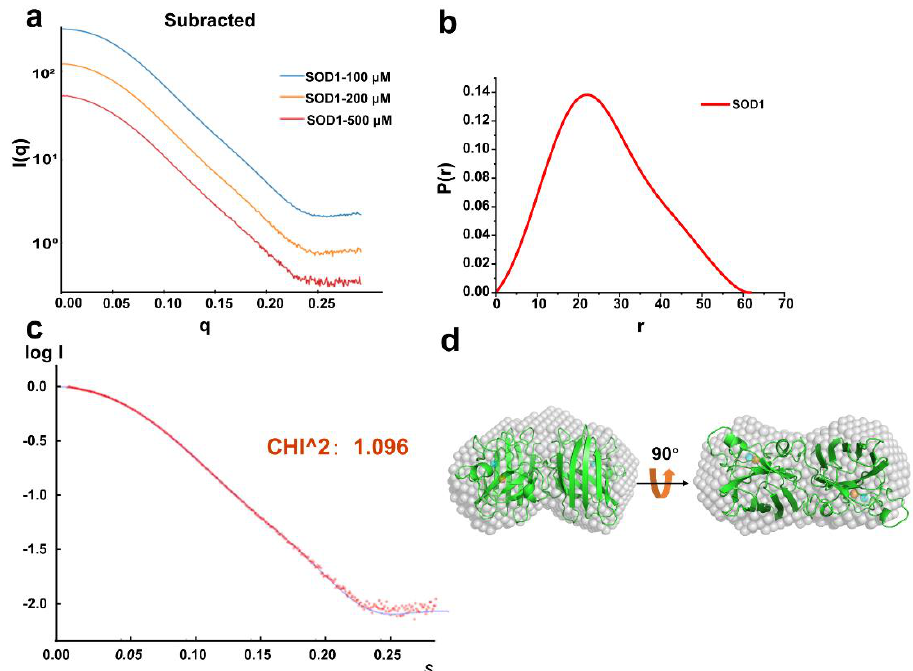
Figure 2. SAXS analysis of SOD1. ( a ) The concentration − dependent scattering profiles of SOD1. These scattering profiles were collected, respectively, at 100, 200, 500 μ M SOD1. ( b ) Distance distribution function P(r) of SOD1. ( c ) Fitting of the SAXS data with the X − ray SOD1 structural data. ( d ) The structural model of SOD1 (white) calculated using the SAXS data was mapped onto the crystal structure of SOD1 (green, 1CBJ). Table 1. The forward scattering [I (0)], radius of gyration (Rg), maximal dimension (Dmax) of samples in